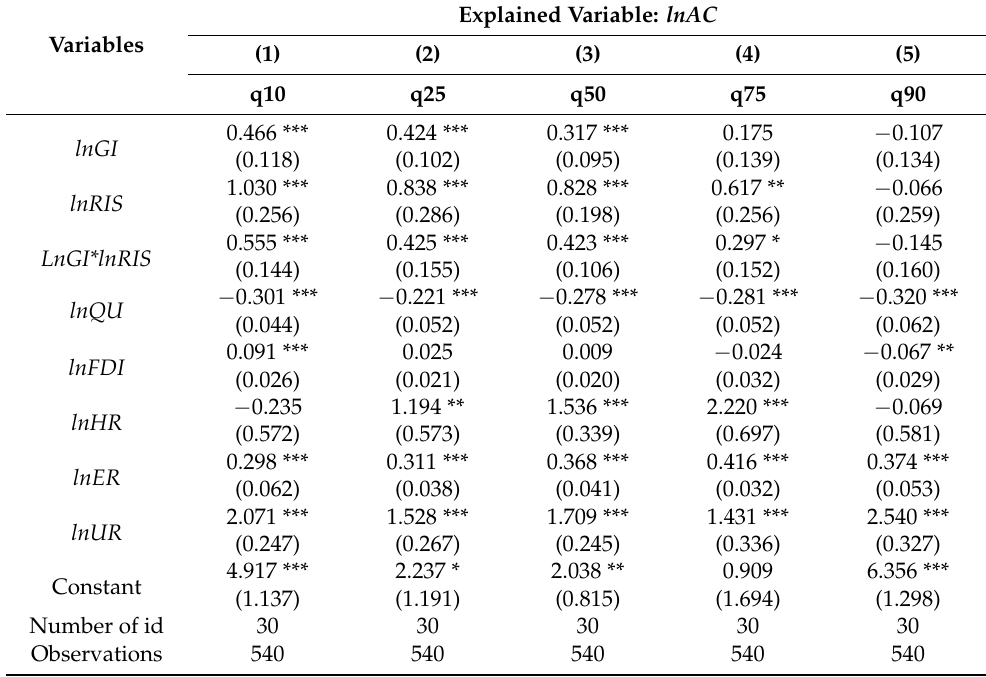
Table 9. Panel quantile regression results for the rationalization of the industrial structure.